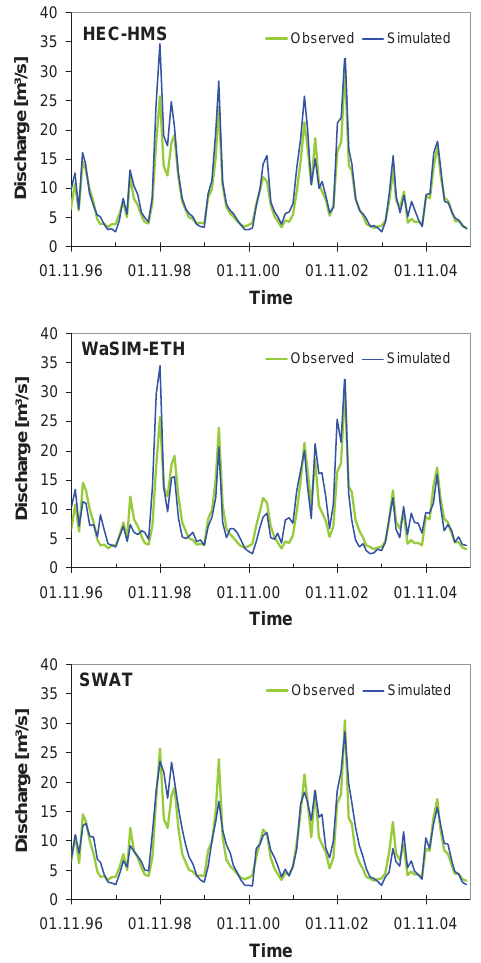
Fig. 2. Observed and simulated monthly discharge time series us- ing the three different models for the validation period at the outlet gauge Leineturm.